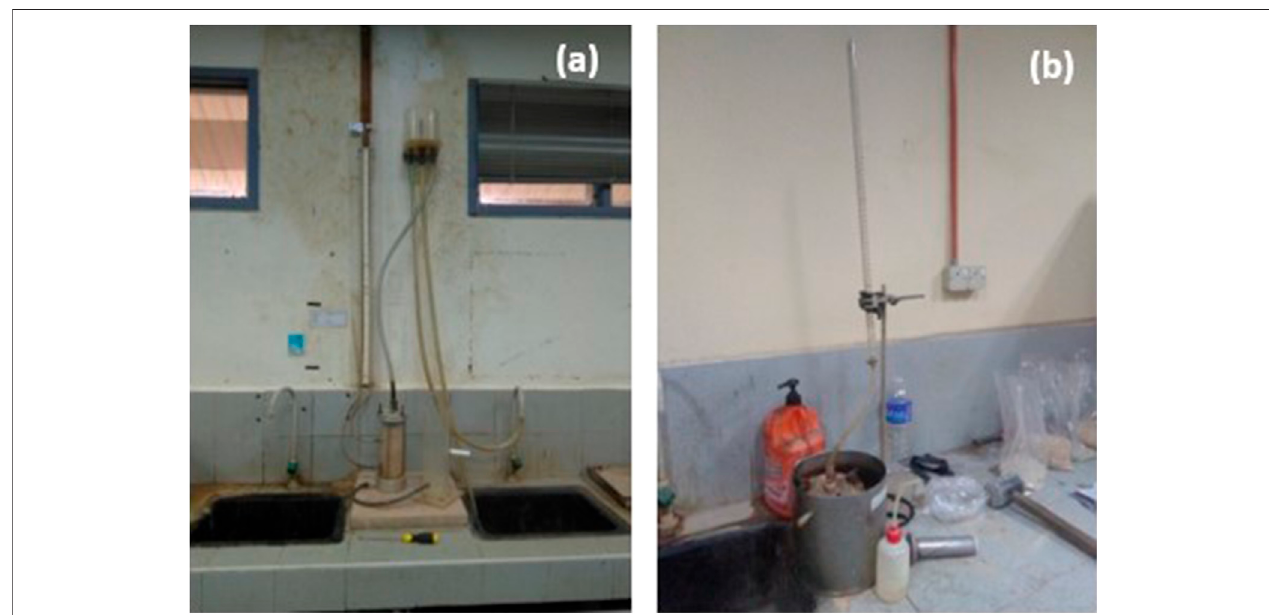
FIGURE 5 | (A) Constant head permeability test and (B) falling head permeability test experimental setup.